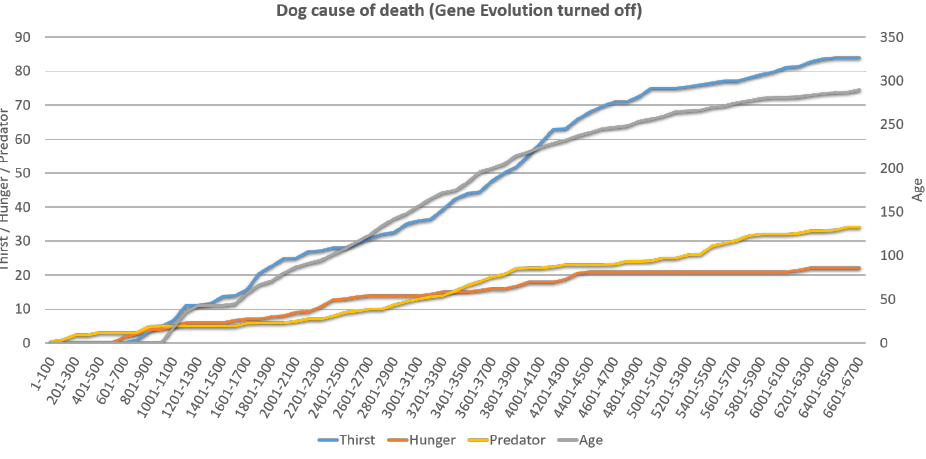
Figure 20. The diagram shows the cause of deaths for the Dog population without